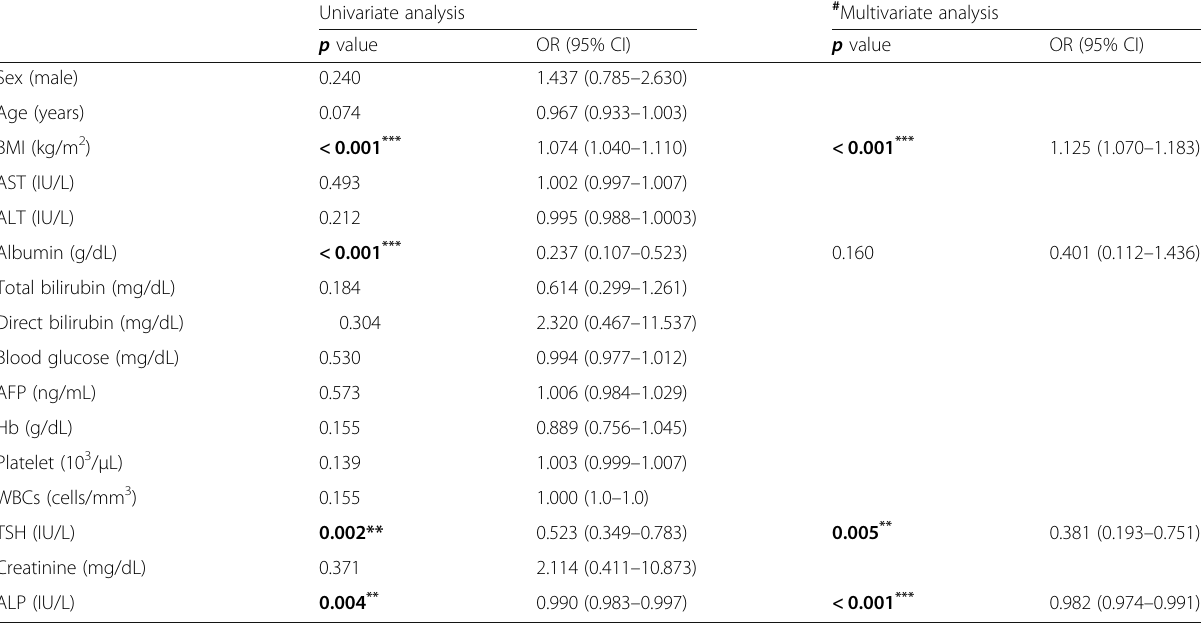
Table 3 Logistic regression analysis of clinical parameters associated with the degree of liver fibrosis in patients infected with HCV genotype